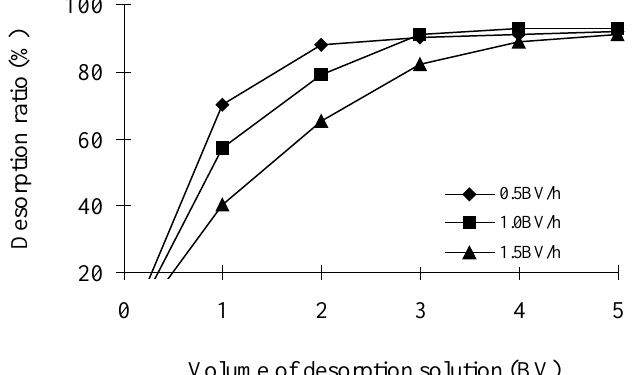
Figure 4. Effect of elution speed and volume of desorption solution on the resin column